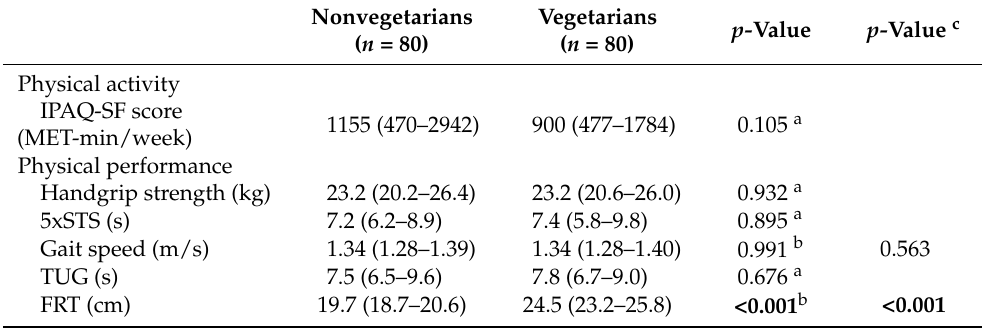
Table 2. Physical activity and physical performance in vegetarians and nonvegetarians.